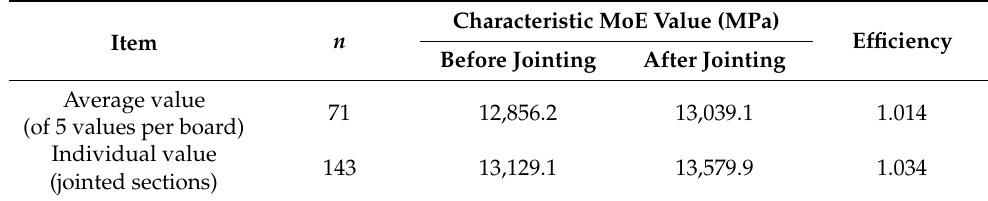
Table 2. Characteristic flatwise MoE values and related finger joint